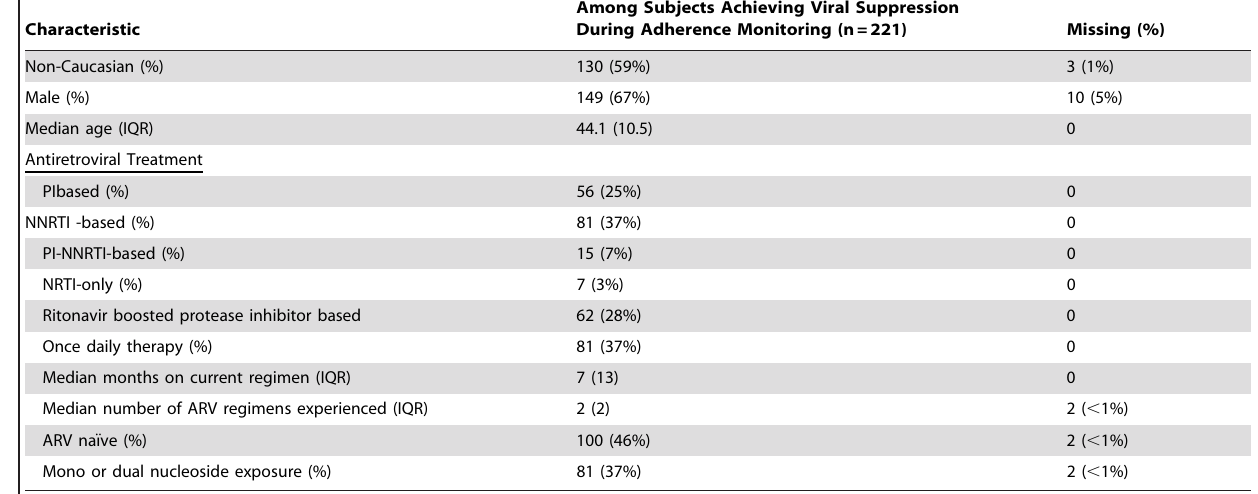
Table 1. Participant Characteristics at Start of Adherence Monitoring.